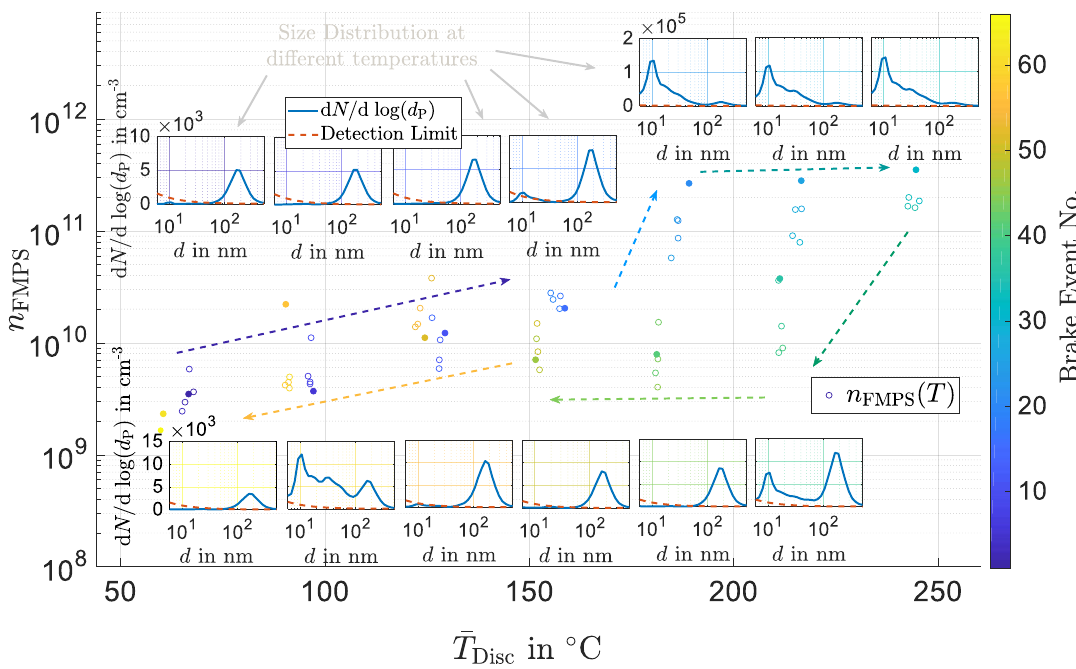
Figure 4. Total number of particles n emitted per brake event plotted versus the average disc temperature T during the brake event for conventional pad material with an organic binder.